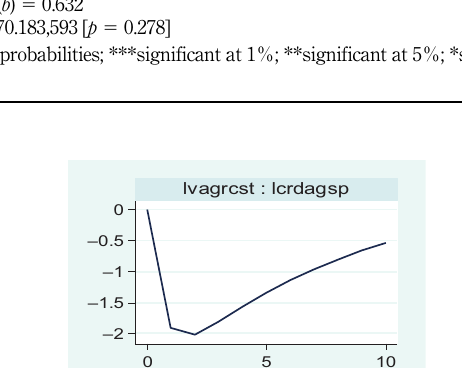
Figure 3. Transmission of